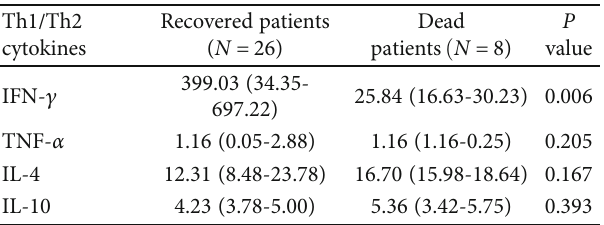
Table 3: Relationship between Th1/Th2 cytokine levels and outcome of